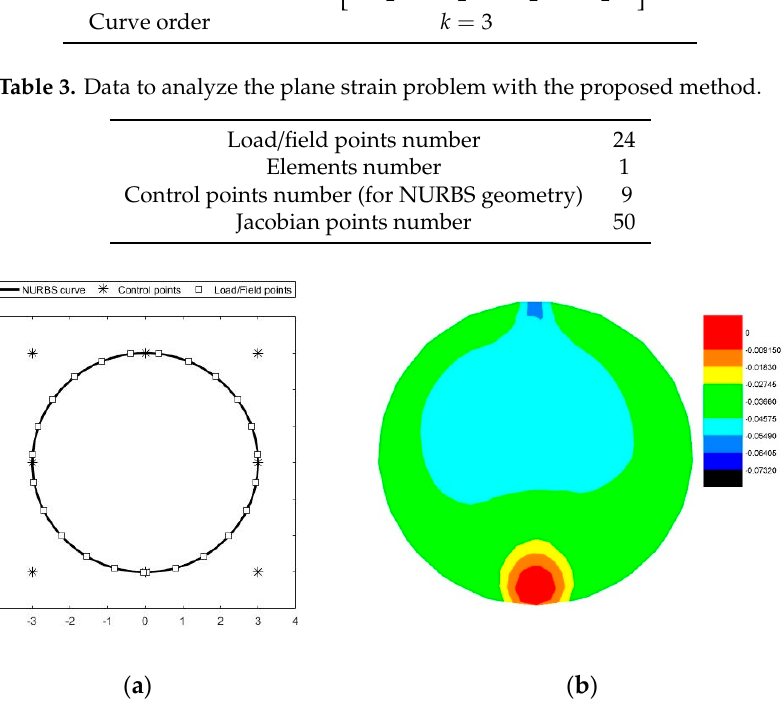
Figure 12. Cylinder under load P solved with the proposed IGA-BEM. ( a ) Load / field points used as analysis point, and control points used to generate the NURB curve. ( b ) Cylinder deformed; the plot colors represent the displacements in Y direction.